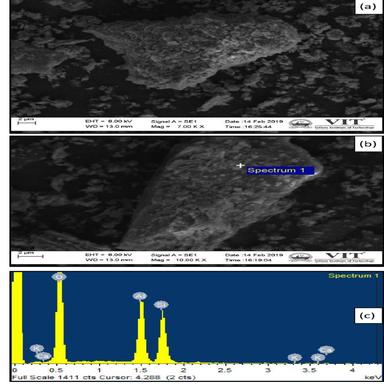
SEM and EDAX spectrum image of metakaolin (a) SEM image of MK (b) SEM image for EDAX spectrum (c) EDAX spectrum of MK particle.